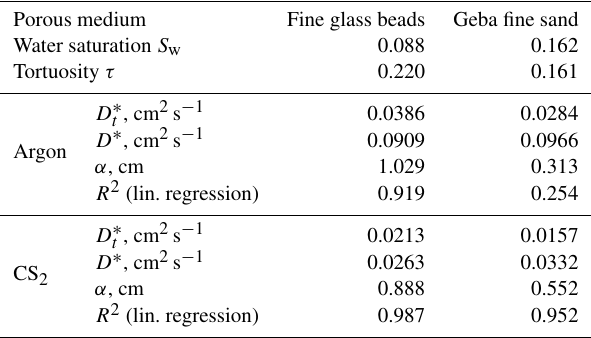
Table 4. Theoretical and experimental effective binary diffusion co- efficient D ∗ of argon and CS 2 , dispersivity α , and coefficient of de- termination R 2 of linear regression determined from experiments in moist porous media (Series